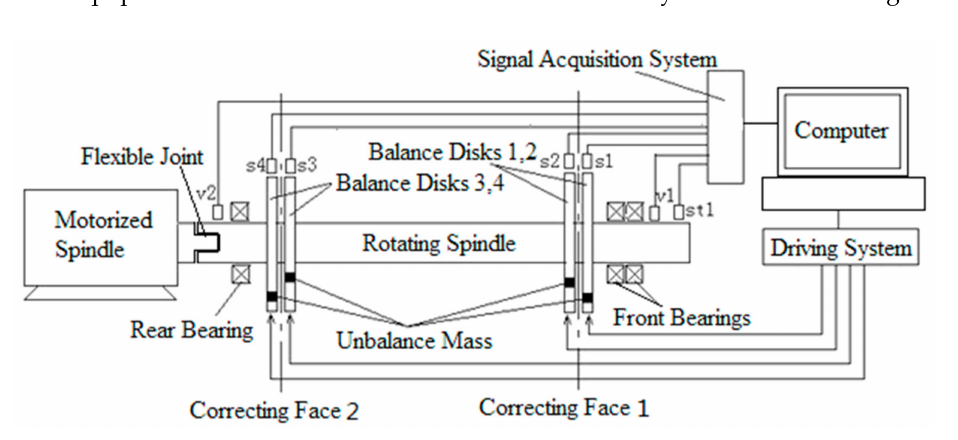
Figure 2. The double-face online dynamic balance